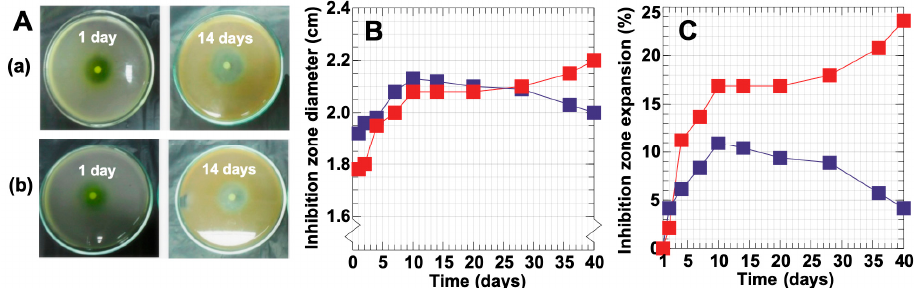
DC-CS-PG (  ) and DC-WCS-PG () NPs Figure 7. ( A ) Photograph of the antifungal efficiency of ( a ) free BBR and ( b ) BBR-loaded DC-WCS- from DC-WCS-PG NPs (  ) in PBS buffer (pH 7.4) compared with free drug (). PG NPs. ( B ) Inhibition zone diameters and ( C ) inhibition zone expansion of free BBR (  ) and BBR- loaded DC-WCS-PG NPs (  ) against S. ampelinum . pHs of 6.5 (  ) and 7.4